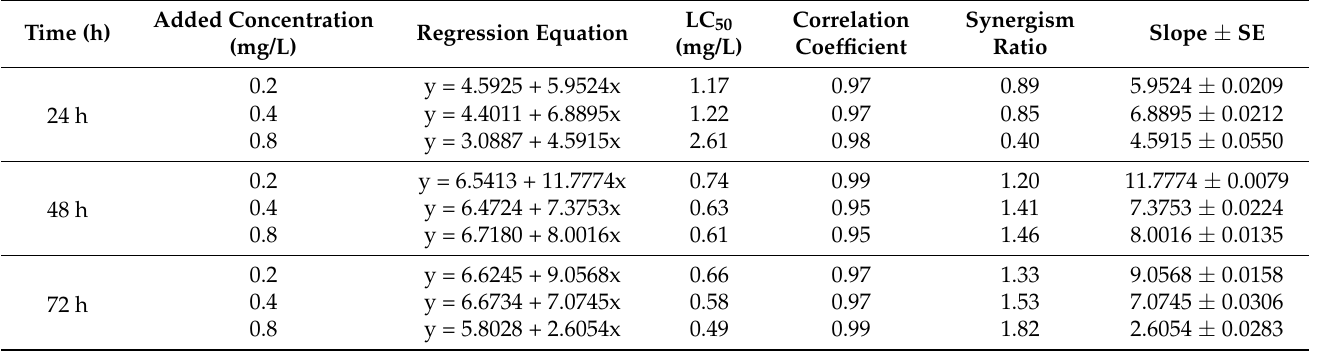
Table 3. Synergistic effects of different concentrations of Pedunsaponin A on NI for P. canaliculata